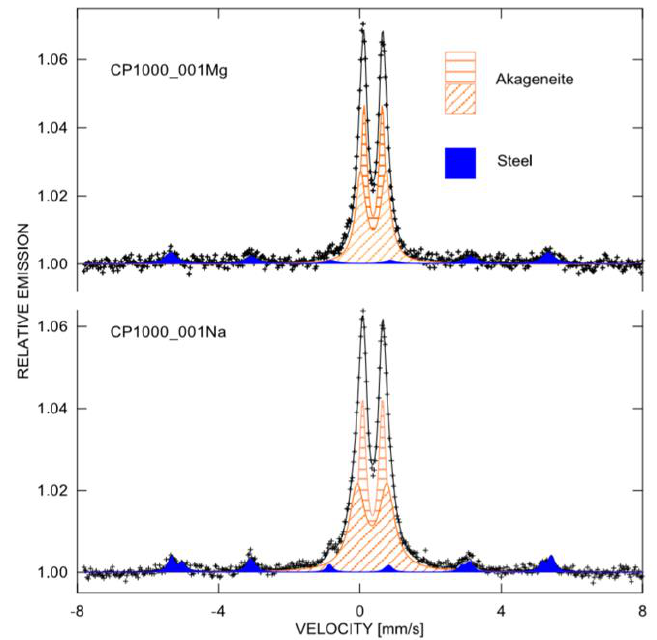
Figure 8. Mössbauer measurements of CP1000 with 0.01 M MgCl 2 solution and 0.01 M NaCl solu- tion.